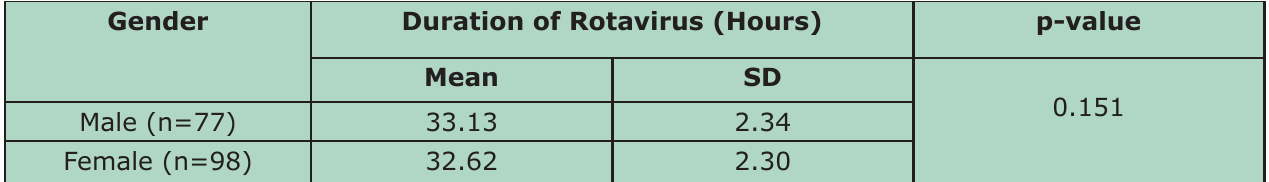
Table-II: Stratification for Mean Duration of Rotavirus Diarrhea in Children After Administration of First Dose of Nitazoxanide with Regards to Gender (n=175).